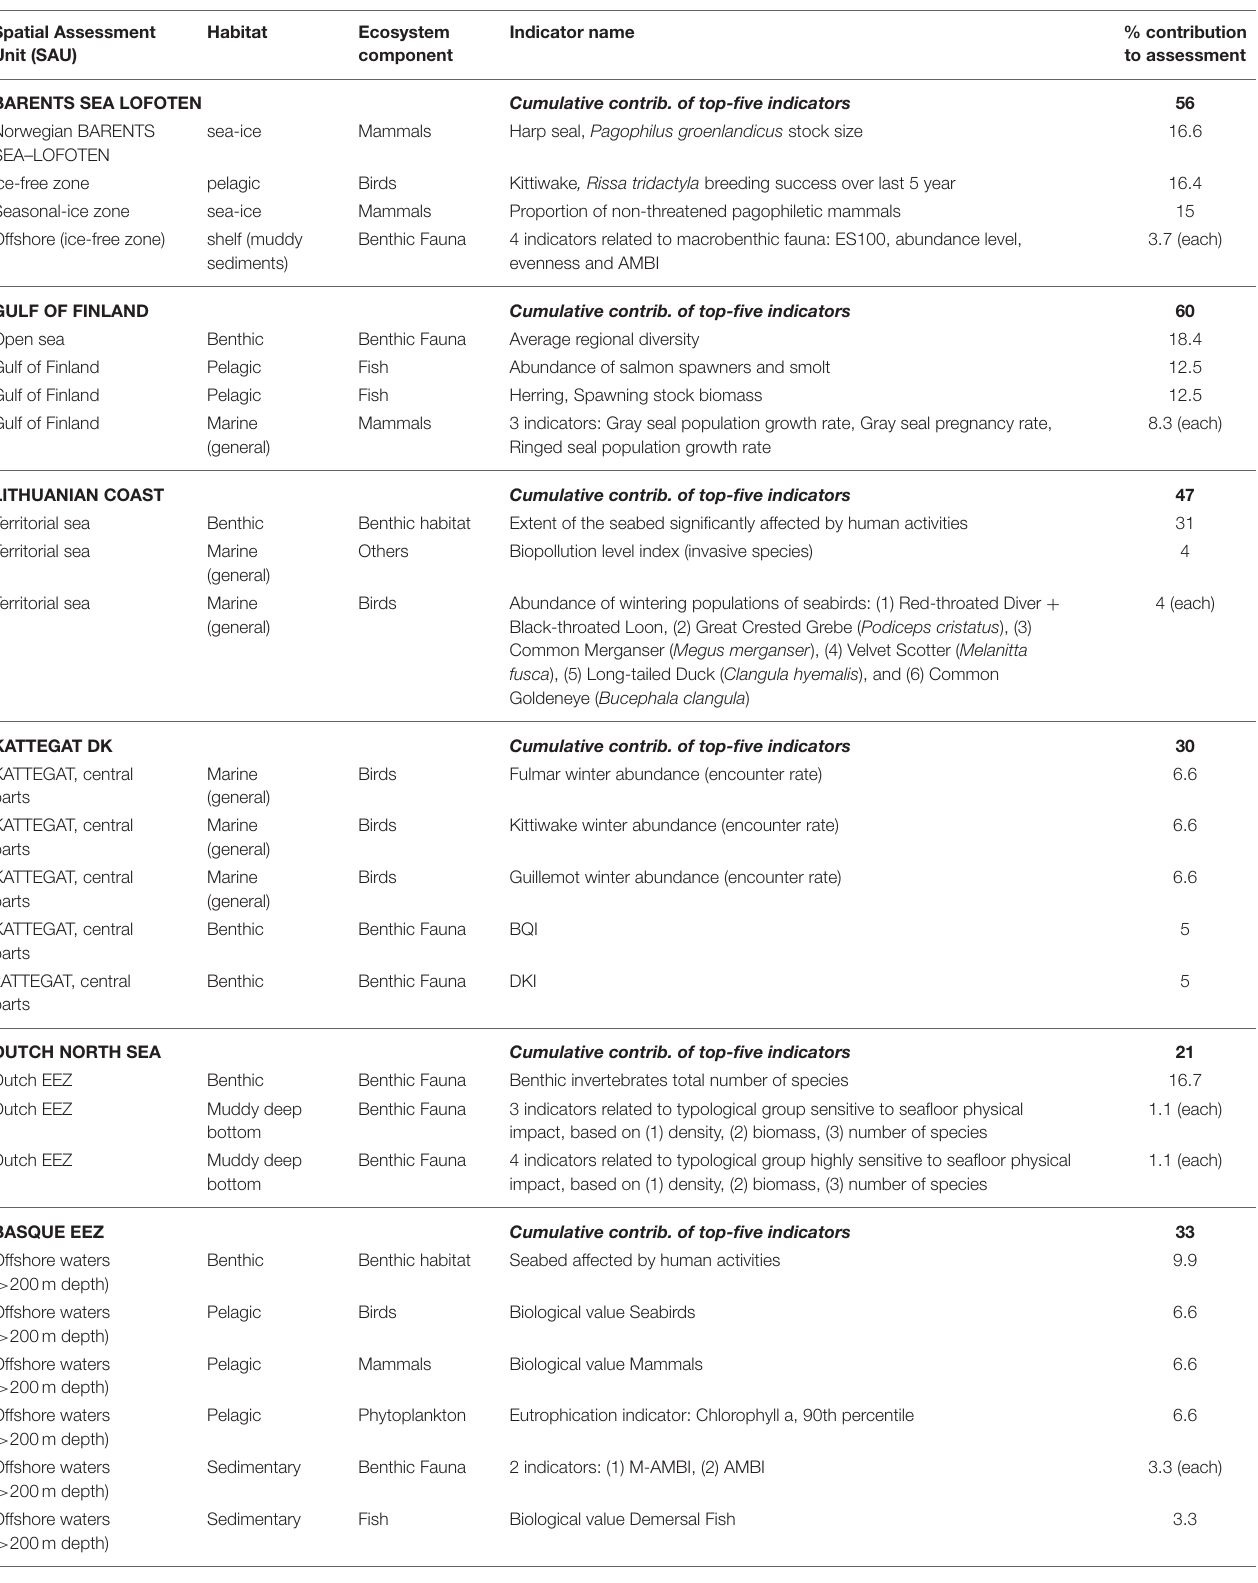
TABLE 3 | List of the top-five indicator values contributing the most to the overall assessment for each case study. Spatial Assessment Habitat Ecosystem Indicator name Unit (SAU) component BARENTS SEA